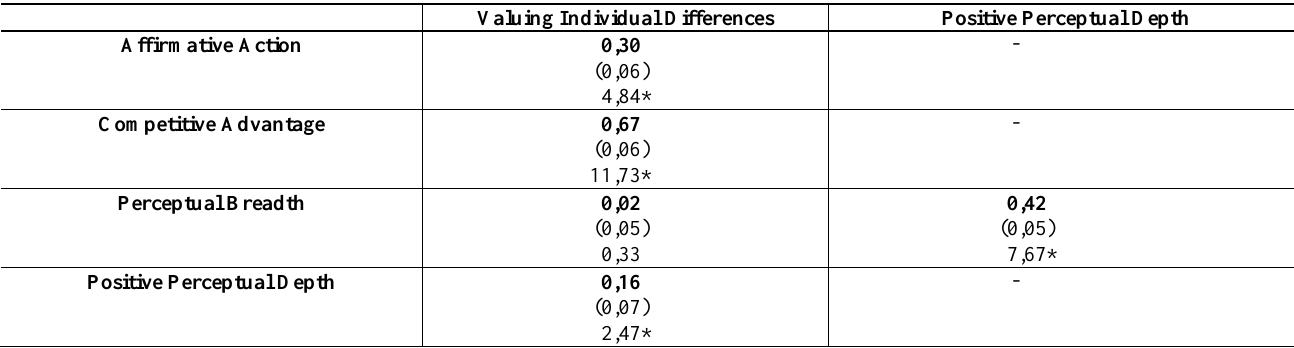
Table 7: Unstandardized beta (  ) matrix Valuing Individual Differences Positive Perceptual